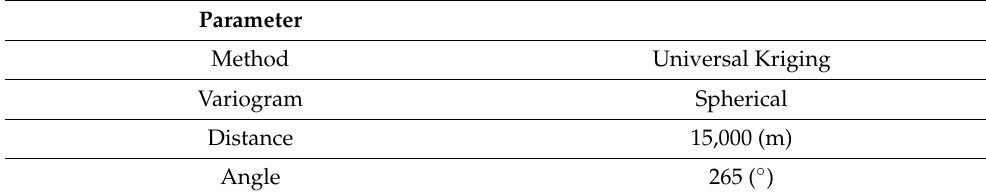
Table 2. Parameters used in